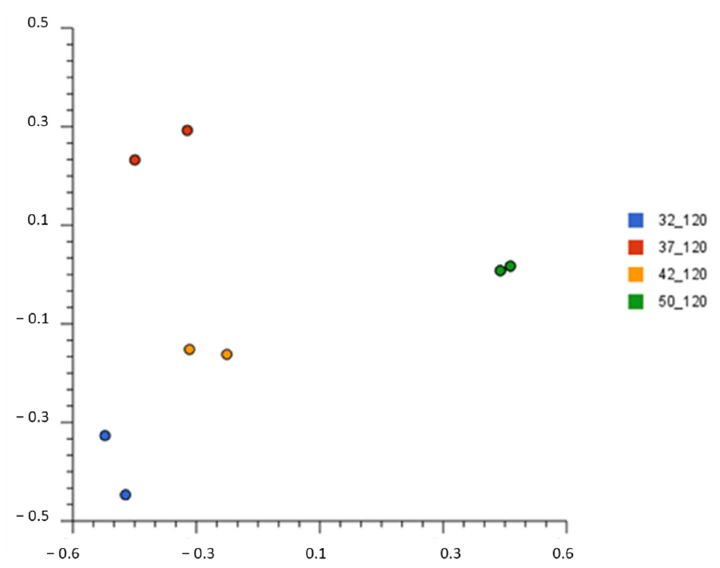
Figure 3. Principal component analysis of whey microbiota (at specie level) after 120 h of fermentation at 32, 37, 42, and 50 °C. The distance among points is inversely proportional to microbiome similarity.